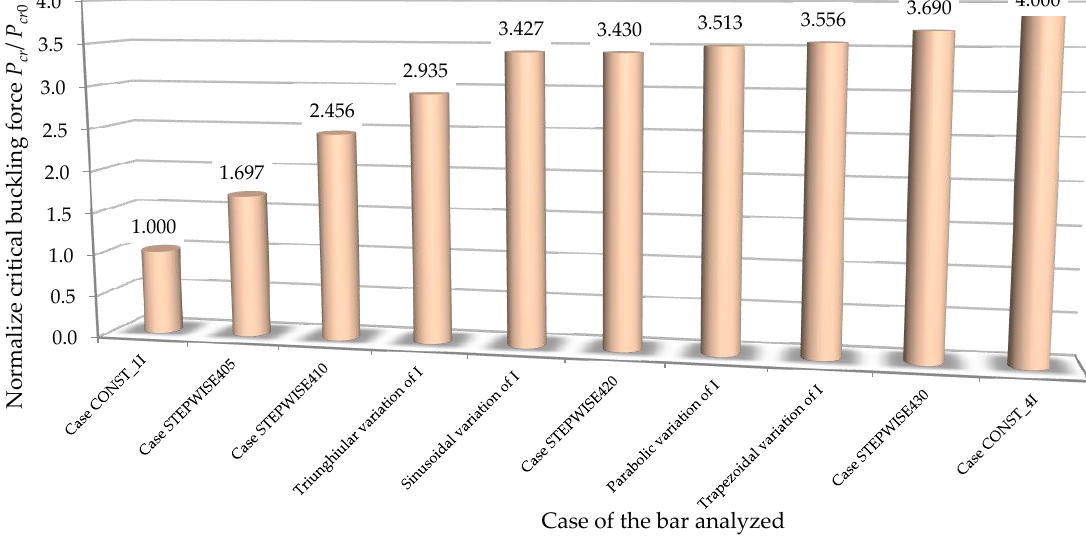
Figure 22. Comparison of the critical buckling force obtained by the FEM for all the cases of bars involved in this research.